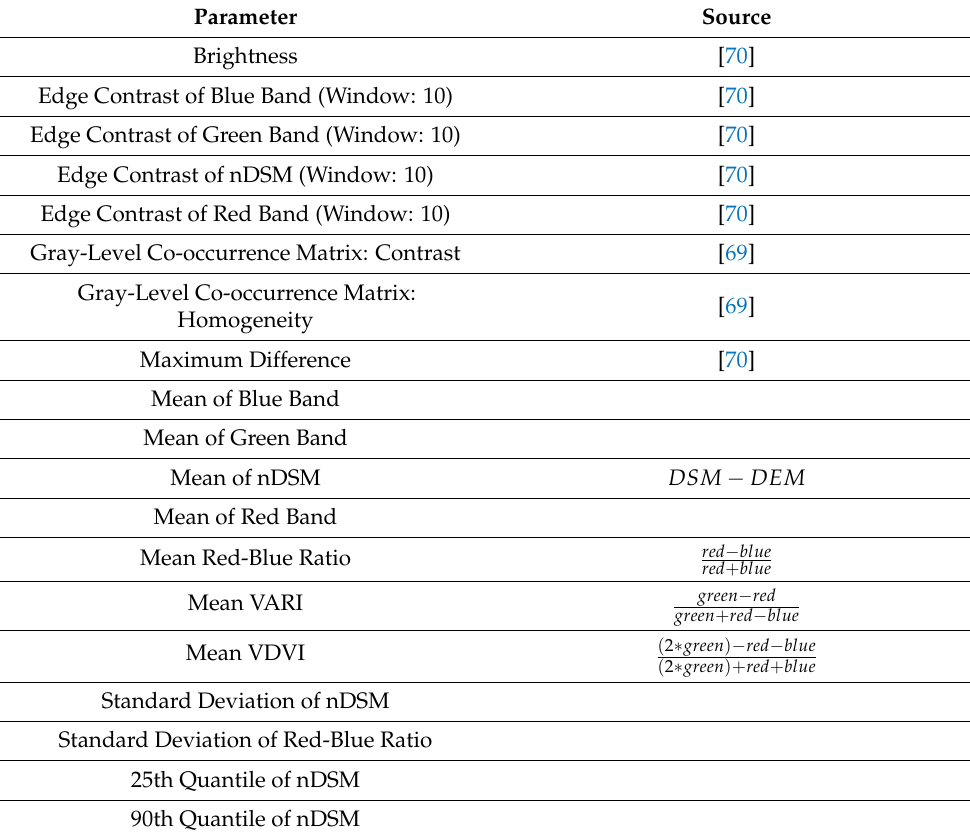
Table 7. Parameters exported from eCognition to be used in machine learning classifiers. Parameter Source Brightness [70] Edge Contrast of Blue Band (Window: 10) [70] Edge Contrast of Green Band (Window: 10) [70] Edge Contrast of nDSM (Window: 10) [70] Edge Contrast of Red Band (Window: 10) [70] Gray-Level Co-occurrence Matrix: Contrast [69] Gray-Level Co-occurrence Matrix: